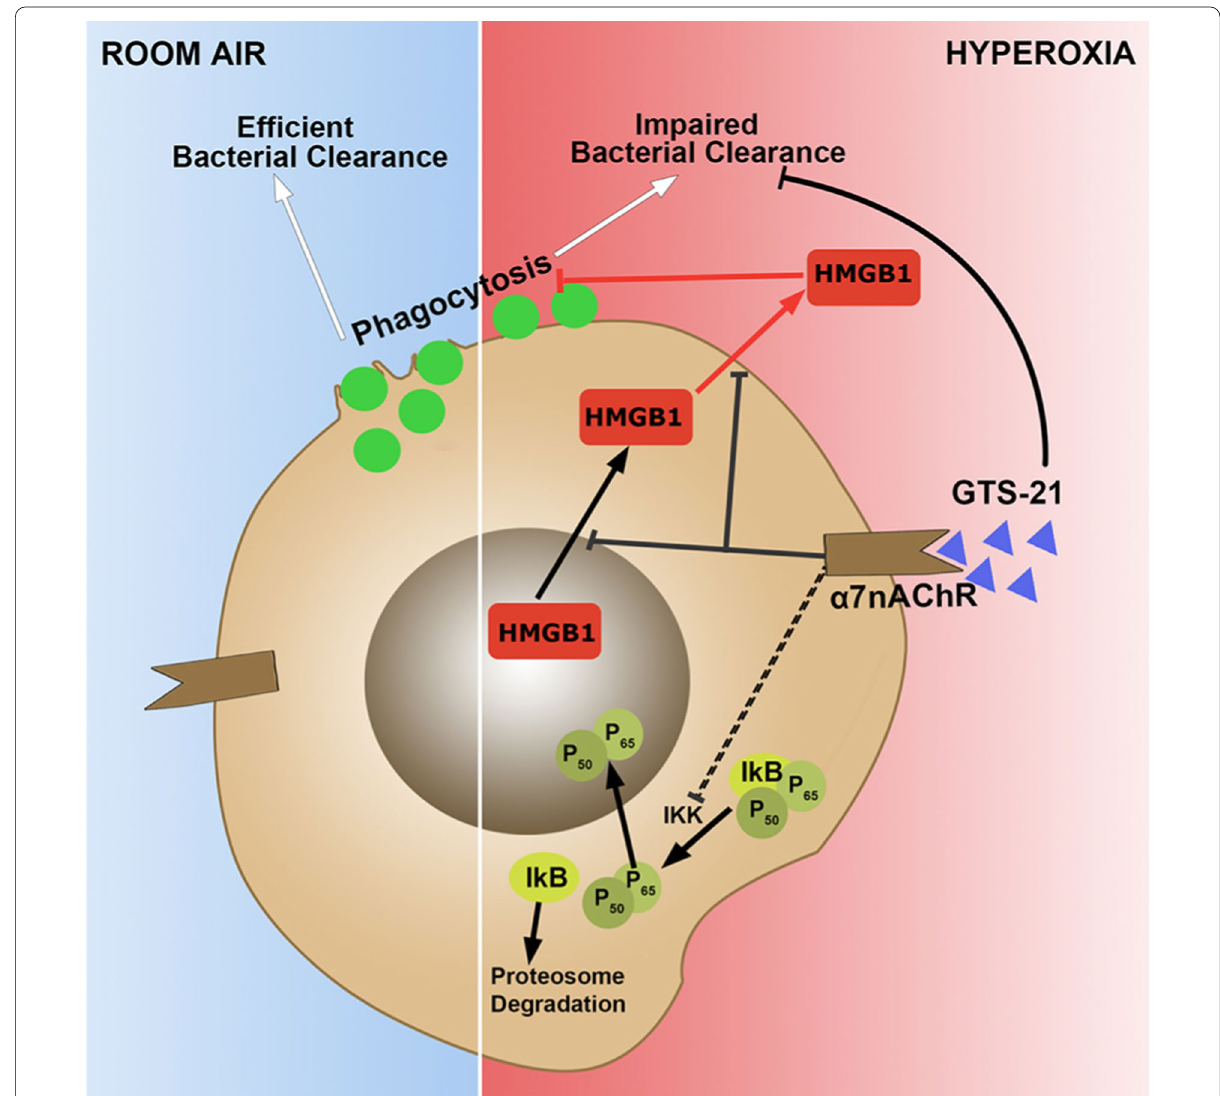
Fig. 6 Hypothesized pathway of GTS-21 inhibited hyperoxia-induced HMGB1 release and improved hyperoxia-compromised macrophage function in bacterial clearance. Under room air conditions, alveolar macrophages (AMs) maintain normal phagocytic activity and efficiently clear bacteria. When macrophages are exposed to hyperoxia, NF-κB p65 subunit is translocated into the nucleus, whereas HMGB1 translocates from the nucleus into the cytoplasm and subsequently into the extracellular milieu, decreasing phagocytosis and bacterial clearance by macrophages. GTS-21 significantly attenuates hyperoxia-impaired bacterial clearance by binding to α7nAChR and suppressing HMGB1 translocation into the cytoplasm and release, which subsequently decreases the accumulation of extracellular HMGB1. GTS-21 also inhibits NF-κB p65 subunit translocation into the nucleus, which may prevent HMGB1 translocation and subsequent release into the extracellular